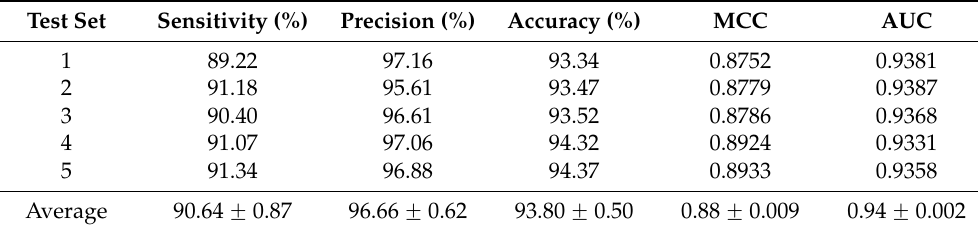
Table 2. The prediction results of the S. cerevisiae dataset using the proposed